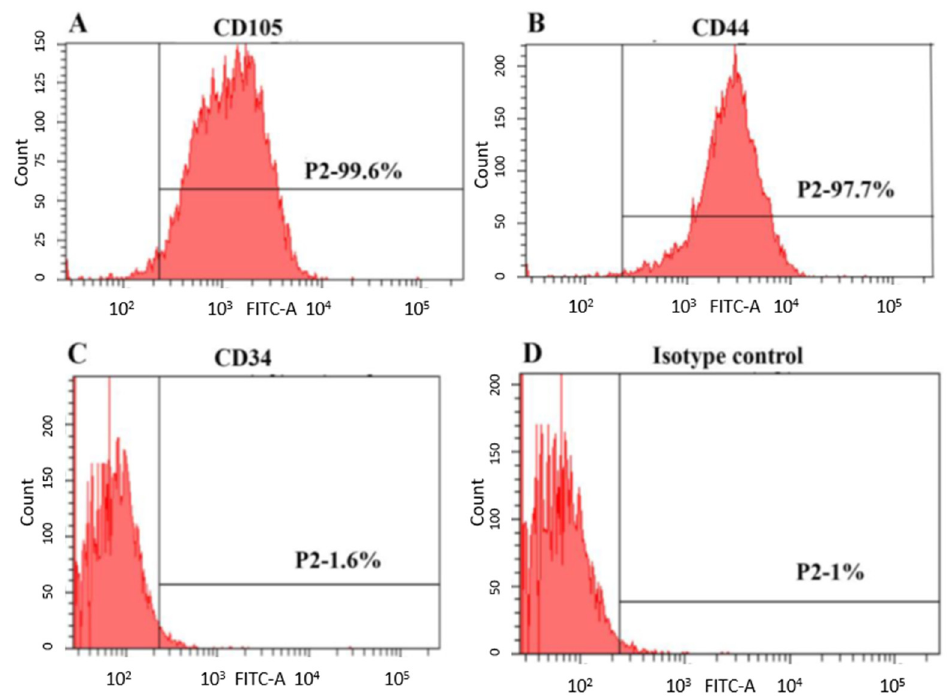
Figure 1. Immunophenotypic characterization of SHED analyzed by flow cytometry. Representative diagram showing the expression of cell surface markers ( A ) CD105, ( B ) CD44, ( C ) CD34 and ( D ) isotype control.